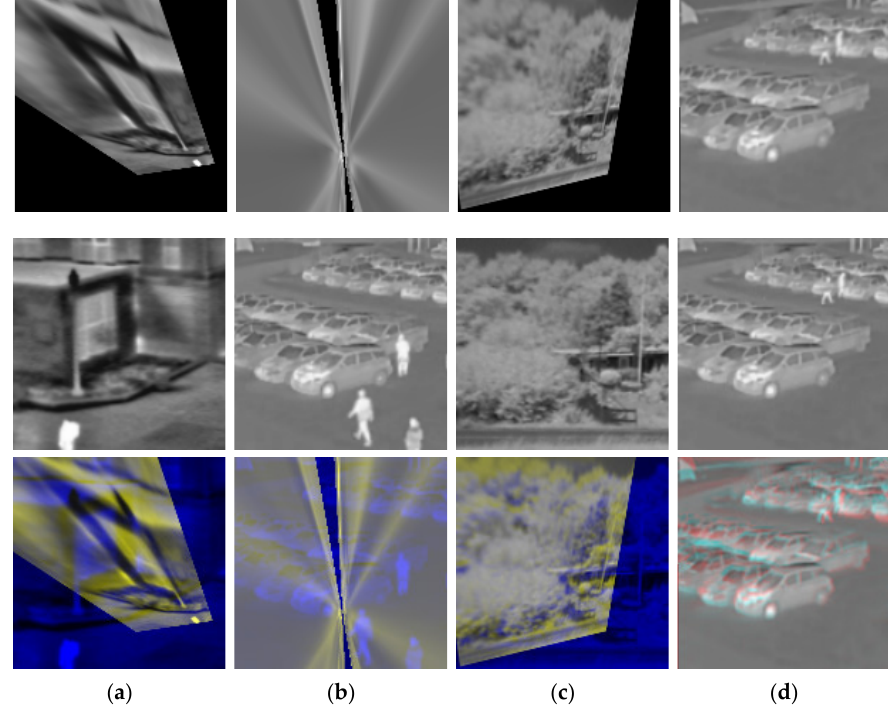
Figure 14. Fusion image comparison of ORB [27] + RANSAC [36] and our method. Row 1 is the infrared warped image. Row 2 is the ground-truth image. Row 3 is the fused image. The fused image is obtained by fusing the blue and green channels of the infrared warped image with the red channel of the ground-truth image, and blue and yellow ghosts represent misaligned pixels. ( a – c ) are from ORB [27] + RANSAC [36], and ( d ) is from our method. Table 7. Comparison of evaluation indicators of four groups of images.